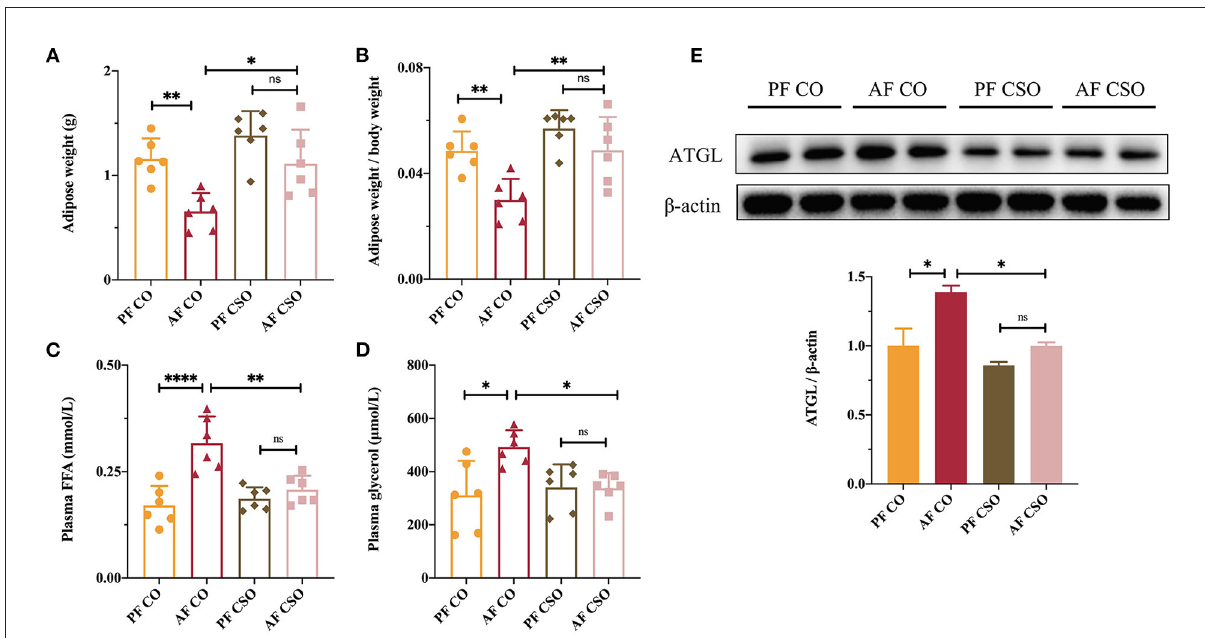
FIGURE7 Dietary CSO supplementation prevents alcohol-induced lipolysis of adipose tissue. (A) The adipose weight. (B) The ratio of adipose-to-body weight. The level of plasma (C) FFA and (D) glycerol among four groups. (E) The expression of ATGL in adipose tissues. * P < 0.05, ** P < 0.01, and **** P < 0.0001 indicate statistically significant.